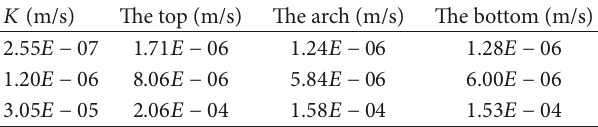
Table 5: The relationship between infiltration rate and the perme- ability coefficient of surrounding rock when